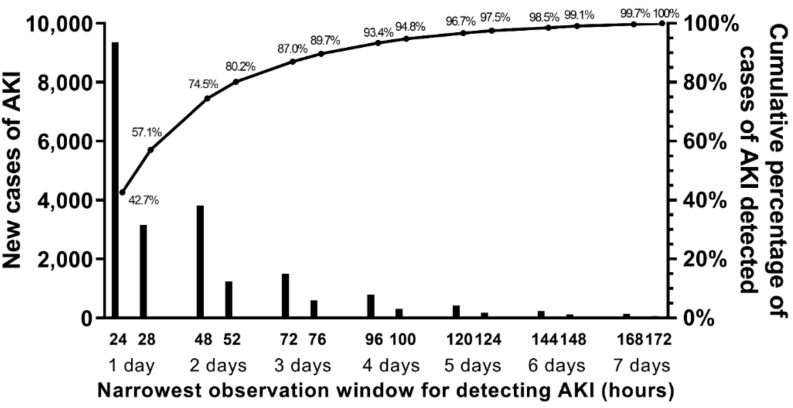
Figure 6. New cases of AKI detected through stepwise expansion of observation window from 24 h to 172 h ( n = 21,894). AKI, acute kidney injury. The bars display the number of new cases of AKI that are detected as the rolling observation window (used to calculate the increase from lowest to highest serum creatinine) expanded from 24 h to 172 h. Count data are shown on the left y-axis. For example, 9357 cases of AKI that were detected using a rolling 24-h window and are shown in the first bar. The second bar at 28 h shows the 3146 new cases that were detected using a 28-h rolling window that were not previously detected using the 24-h rolling window. By moving right on the x-axis, each bar shows the number of new cases that were not previously detected by narrower observation windows. Cumulative percentage is displayed on the right y-axis. The solid line represents the cumulative percentage of the 21,894 cases of AKI detected at each specific observation window using data from that observation window and all narrower observation windows.